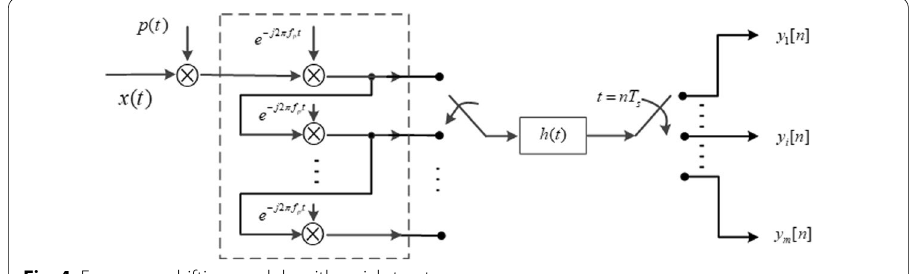
Fig. 4 Frequency shifting module with serial